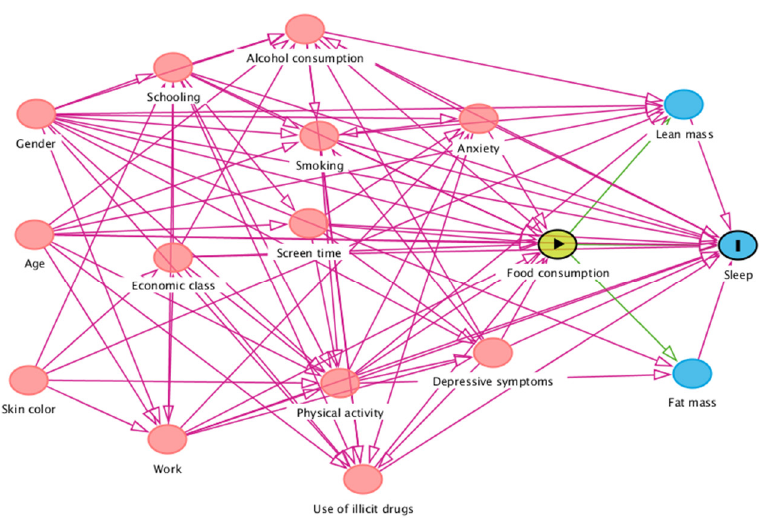
Figure 2. Directed acyclic graph regarding the association between food intake and sleep duration.